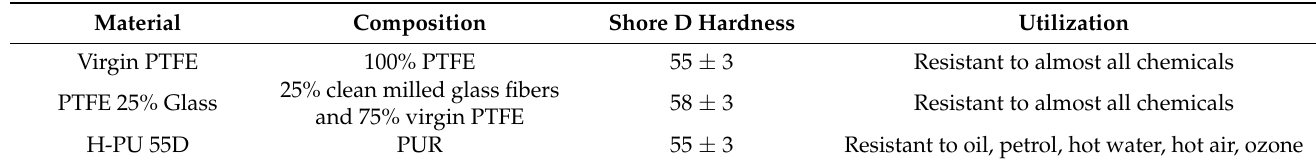
Table 1. Characteristics of seal materials.